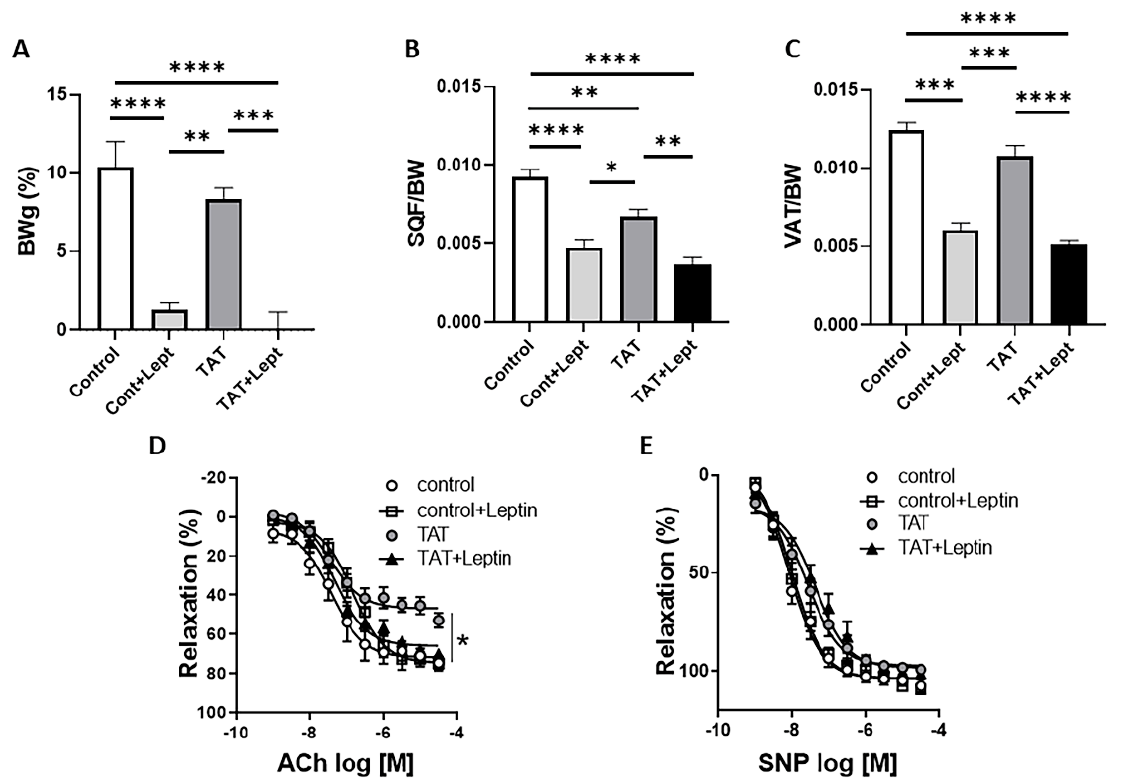
Figure 4. Leptin restores TAT-induces endothelial dysfunction in mice. Body weight ( A ), subcutaneous fat depot (SQF/BW; B ), visceral fat depot (VAT/BW; C ), concentration response curves to acetylcholine (Ach; D ) and sodium nitroprusside (SNP; E ) in aortic rings from control (vehicle-treated) and TAT-treated mice (TAT, 3.2 µ g/kg per day for 4 weeks, i.p.) in the presence or absence of leptin treatment (0.3 mg/kg per day for 7 days, via osmotic minipump). Data are presented as mean ± SEM. n = 5–6; * p < 0.05; ** p < 0.01; *** p < 0.001, and **** p < 0.0001 vs. Ctrl.